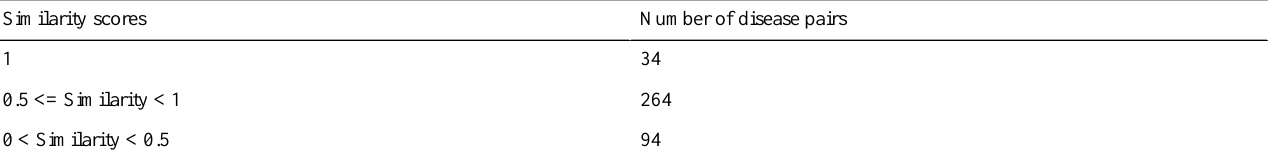
Table 3. Similarity calculation results for disease pairs (n=392).